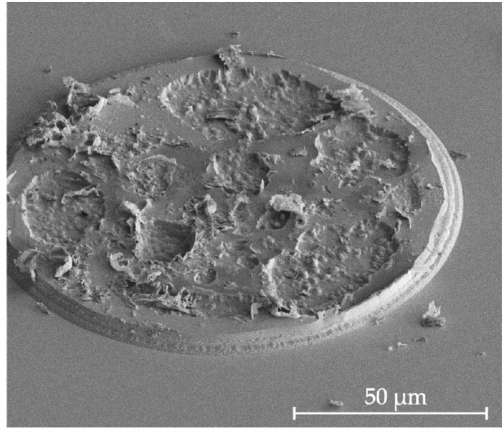
Figure 5. Severe reticulation of a 3.5- µ m thick Olin OiR 908-35 photoresist used to pattern a 120- µ m large